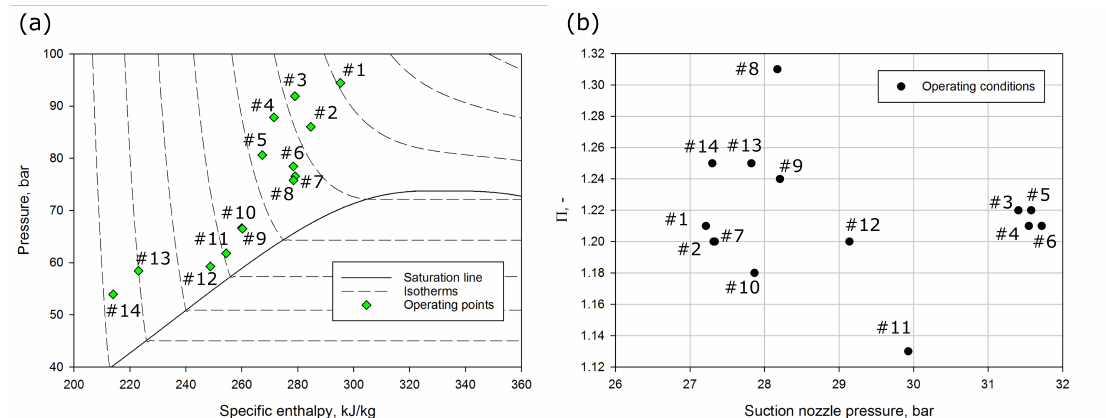
Figure 5. Selected operating conditions: ( a ) the motive nozzle conditions on the R744 pressure-specific diagram; ( b ) the pressure ratio in terms of the suction nozzle